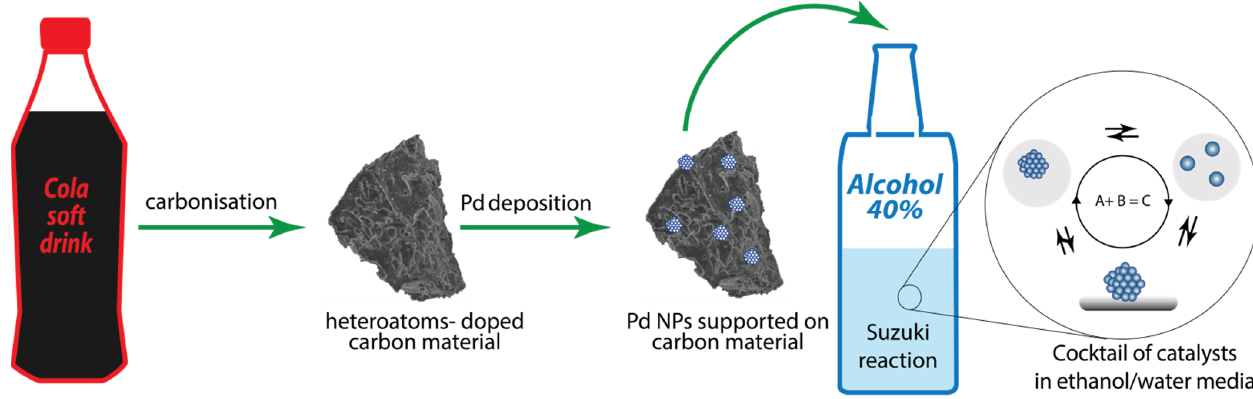
Figure 1. Scheme of supported Pd catalyst preparation from cola, and catalyst application in the cross-coupling reaction and formation of a cocktail of catalysts in an ethanol/water reaction mixture.